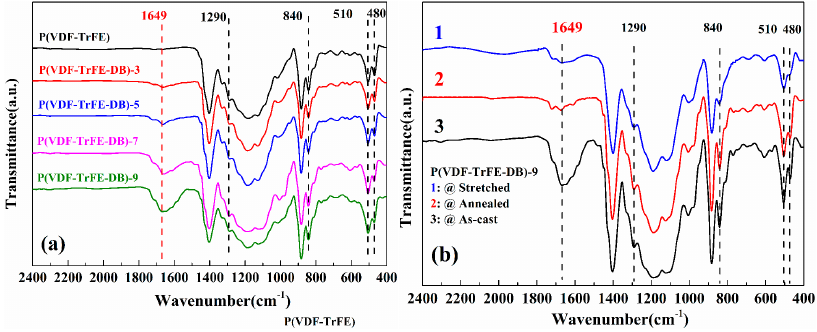
Figure 2. Fourier transform infrared ( FTIR) spectra of the as-cast P(VDF-TrFE) (80/20 mol %) and P(VDF-TrFE-DB)s with different composition ( a ), and P(VDF-TrFE-DB)-9 with different treatment conditions ( b ).